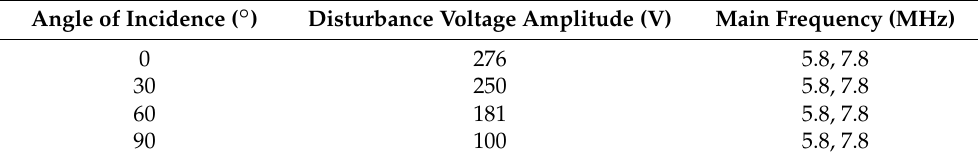
Table 1. The influence of the horizontal component of the magnetic field on the radiation disturbance. Angle of Incidence ( ◦ )